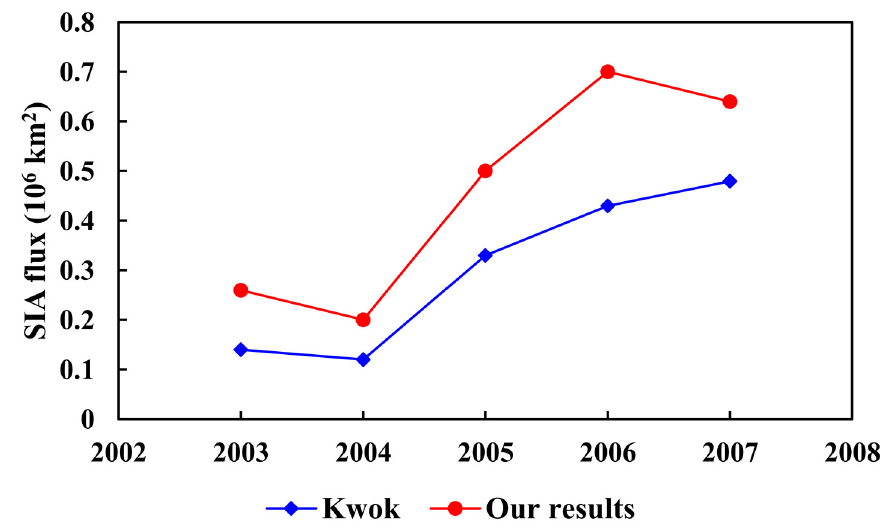
Figure 9. Comparison of June–September SIA flux from the Pacific sector to the Atlantic sector during 2003–2007 between our results and [19].